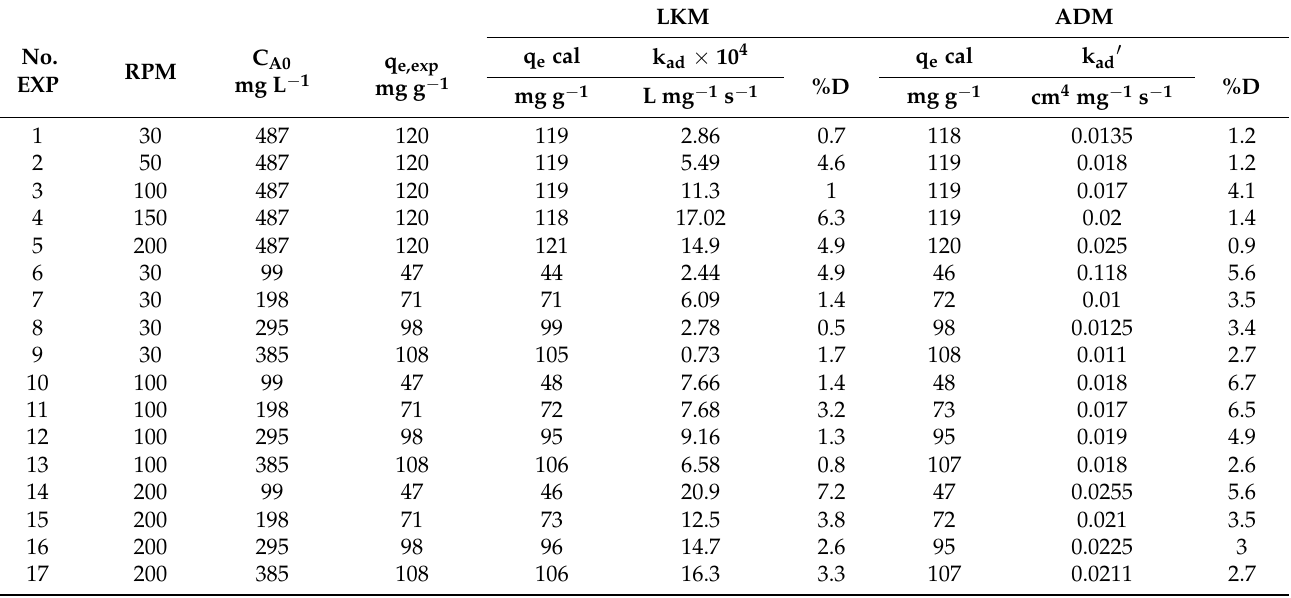
Table 3. Kinetic parameters and experimental conditions used to obtain the adsorption rate of pyridine on